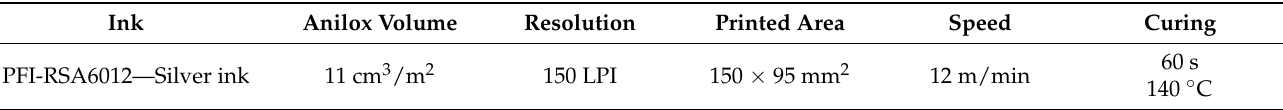
Table 4. Printing